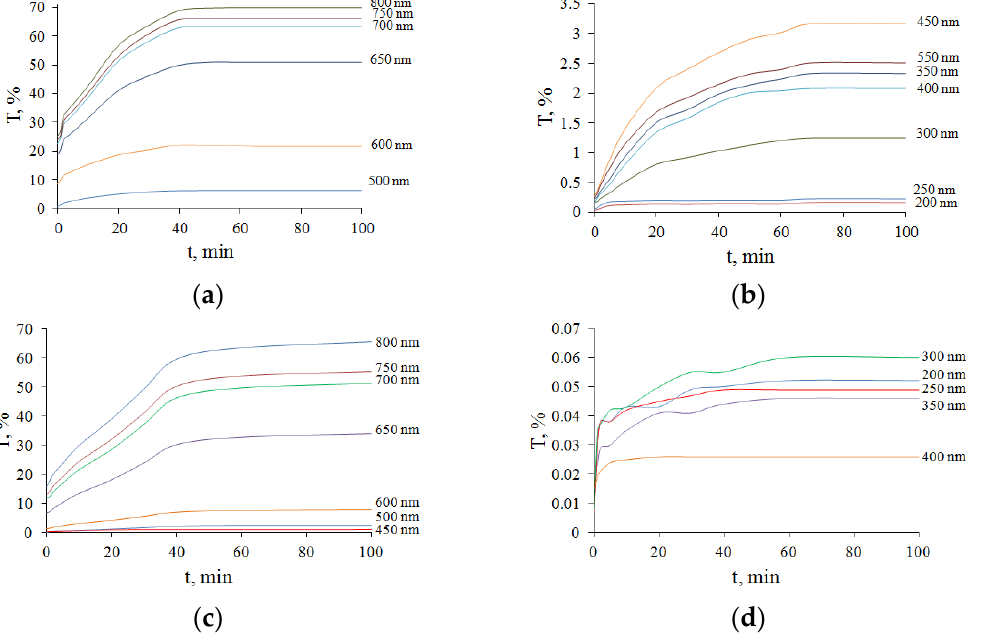
Figure 12. The kinetics of the total optical transmittance T ( t ) of cat ovarian tissue samples for different wavelengths λ when exposed to 99.5% glycerol: ( a , b ) F-ph; ( c , d ) L-ph. The efficiency of optical clearing under the influence of 99.5% glycerol ( Q , %), deter-